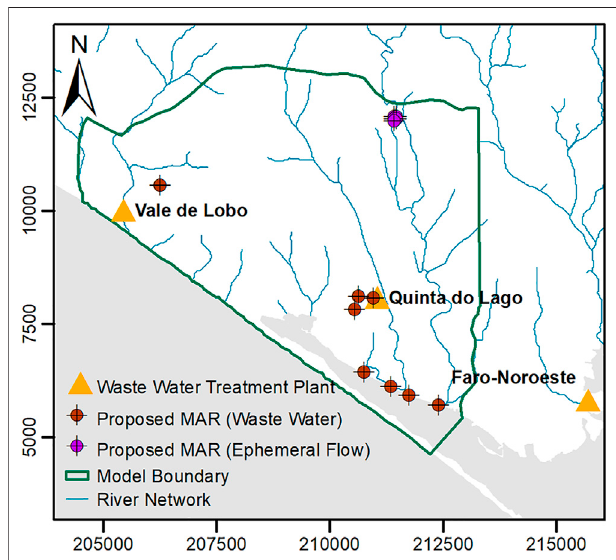
FIGURE 3 | Locations of wastewater treatment plants and proposed MAR borehole